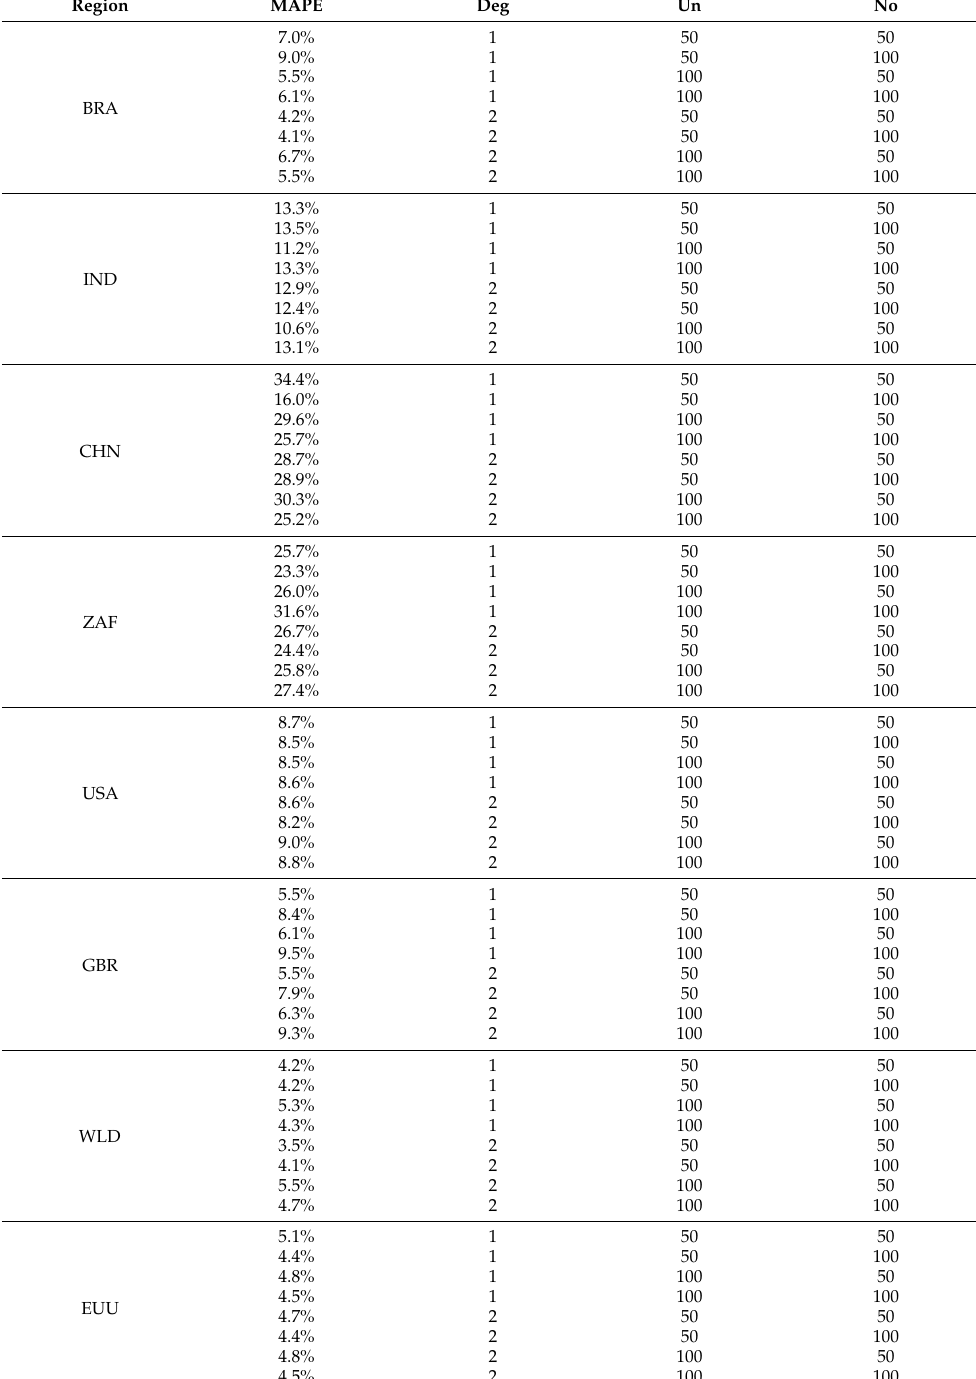
Table 11. Mean absolute percentage error (MAPE) on the test set using deep neural networks for different values of the degree of the polynomial (Deg), number of neurons per hidden layer (Un), and number of epochs